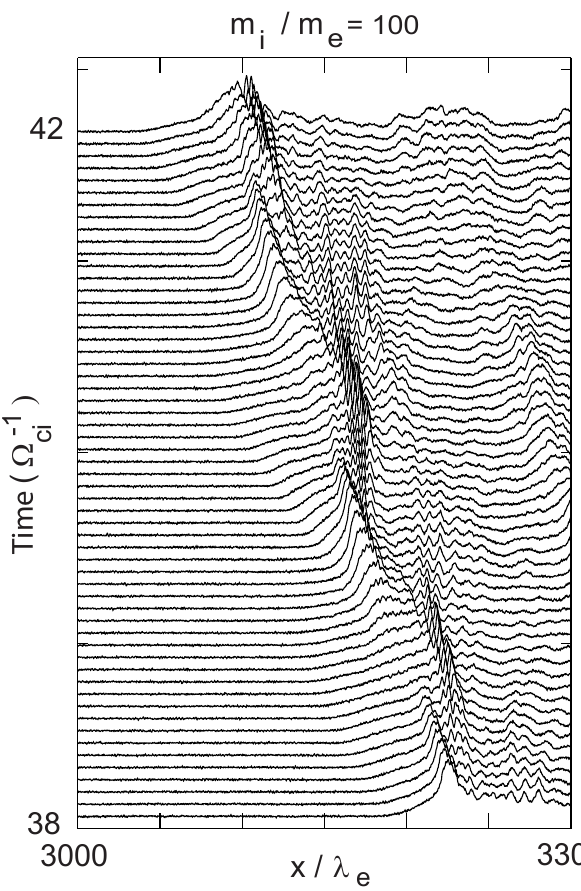
Fig. 10. Stacked profiles of the magnetic field B z component for the ion to electron mass ratio 100